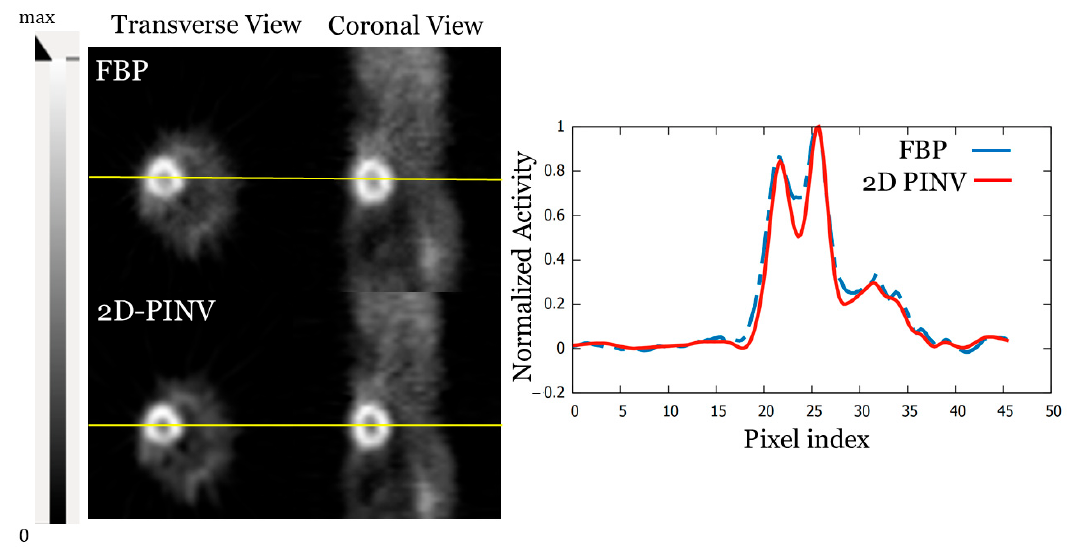
Figure 9. FBP and 2D-PINV reconstruction of a 15 g mouse injected with 170 µ Ci of 18 FDG from data rebinned using PINV. A profile along the heart is also shown.